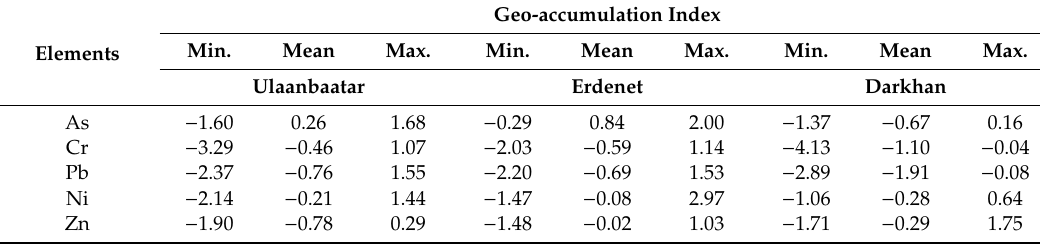
Table 5. Geo-accumulation index of heavy metals in urban soil in the major cities from